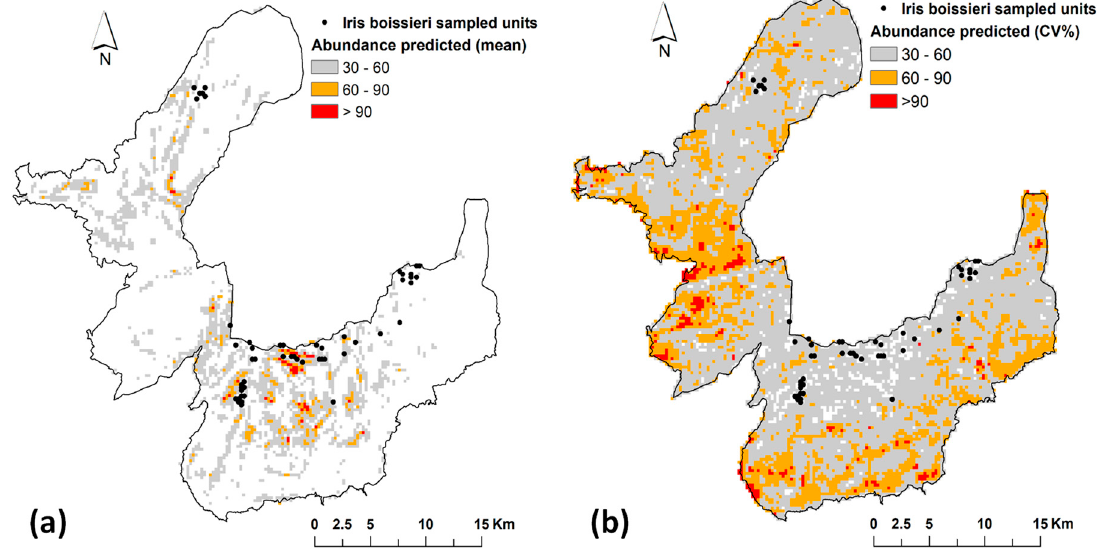
Figure 3. Spatial projections of predicted Iris boissieri abundance representing the variability of the species populations based on: ( a ) inter-annual mean; and ( b ) inter-annual coefficient of variation (CV) for the whole 2001–2016 time-period based on the EFAs + SLO model. Blank cells represent values < 30.